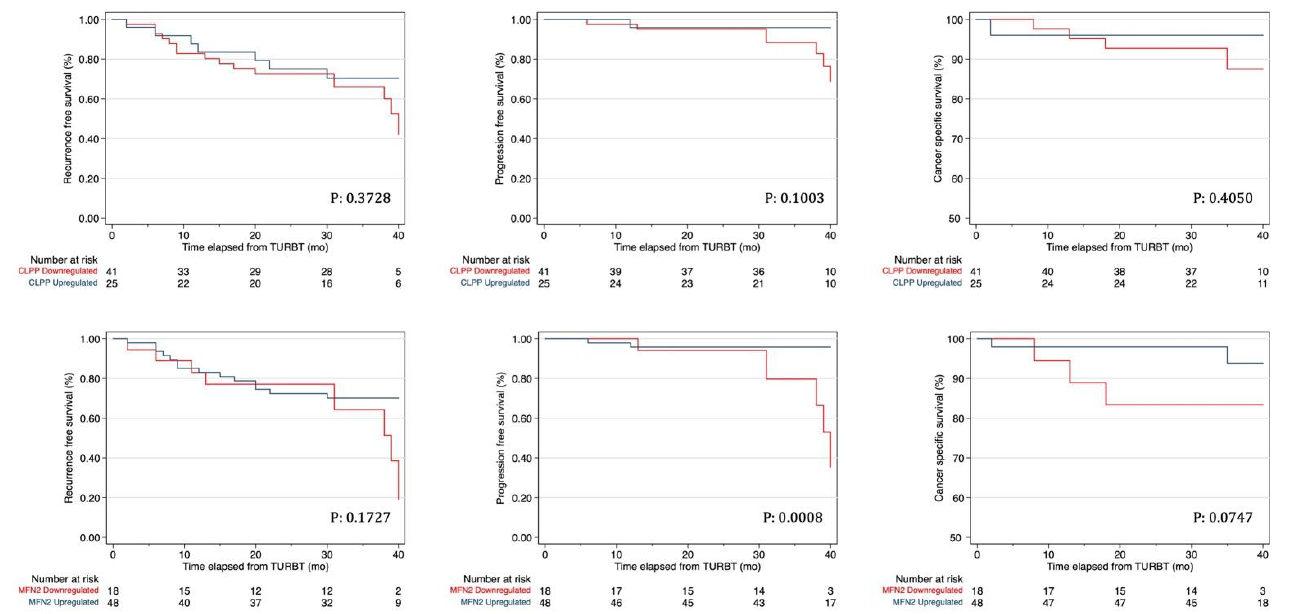
Figure 2. Kaplan–Mayer curves for recurrence, progression, and cancer-specific survival in patients with NMIBC according to down- and upregulation of Mfn2 and ClpP.